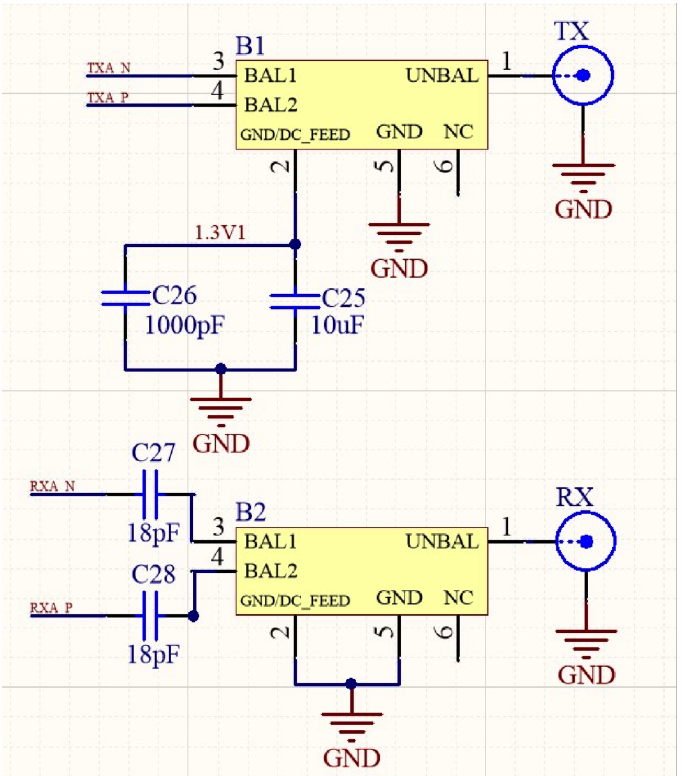
Figure 6. The RF matching stage, designed to avoid interference for 2–3